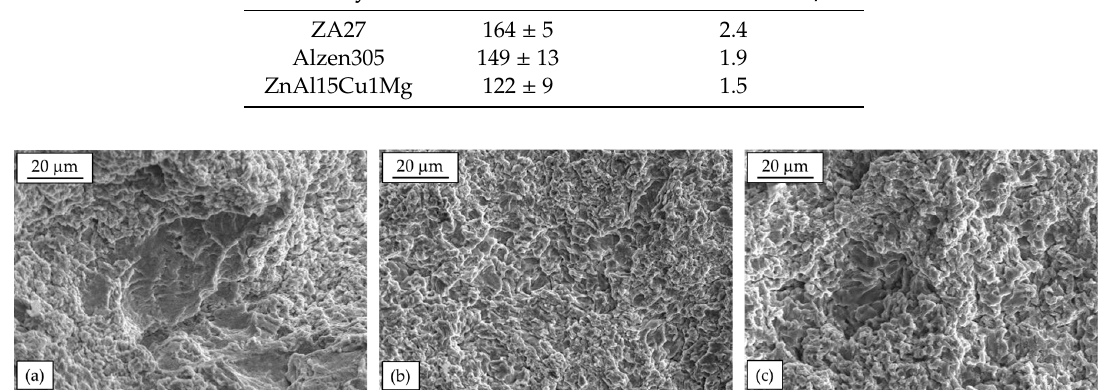
Table 3. Hardness and erosion rate according to ASTM G32 standard (based on data from [67]). Alloy